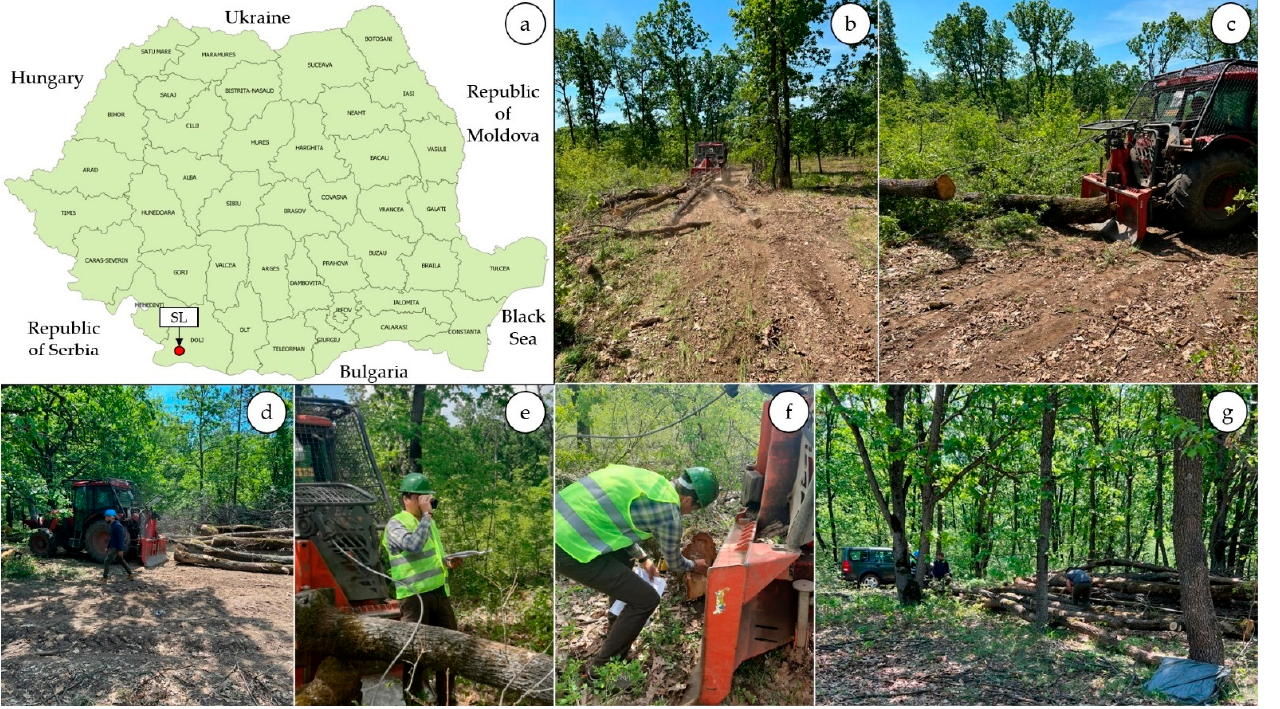
Figure 1. Study location and examples from operation and data collection activities: ( a ) location of the study area at the national level; ( b ) a snapshot taken during the loaded turn; ( c ) a snapshot taken during mechanical traction of logs; ( d ) wood piles at the roadside; ( e ) distance measurement during the winching operations; ( f ) piece-by-piece numbering by marking of the winched logs once they arrived at the rear part of the tractor; ( g ) log measurements taken at the roadside by marking segments, taking diameters by a caliper and lengths by a tape. Table 1. Description of the study